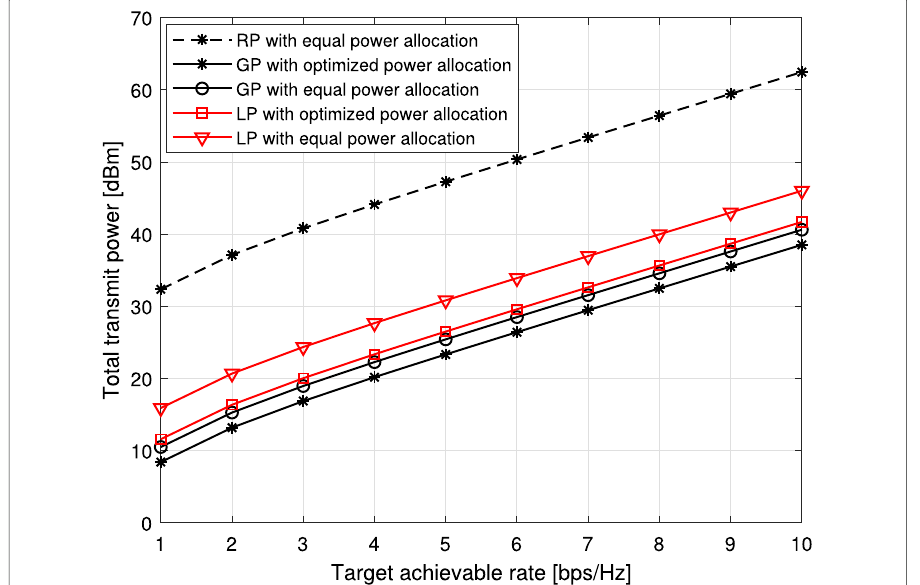
Fig. 7 Performance comparison under different